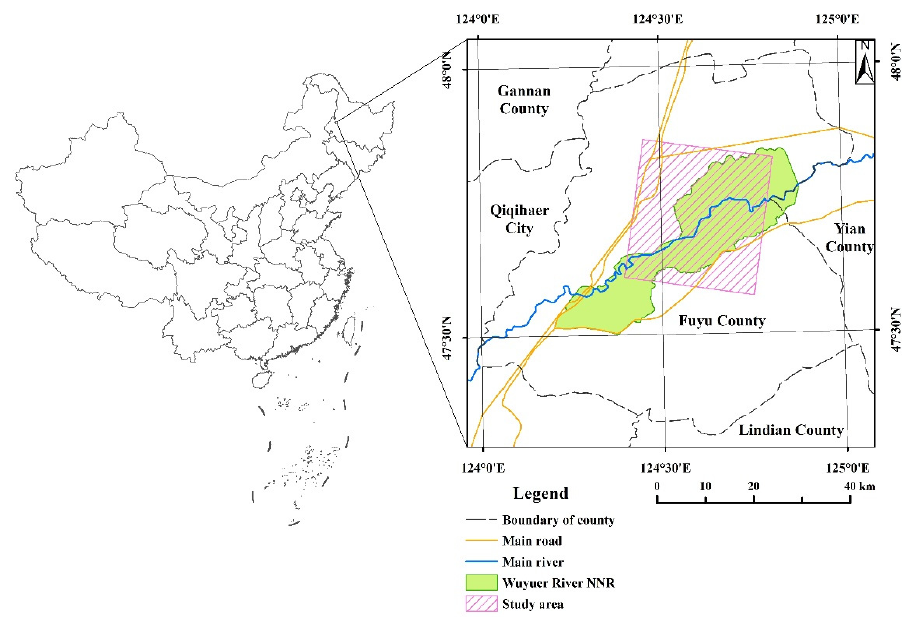
Figure 1. The location of the study area in the Wuyuer River Wetland National Natural